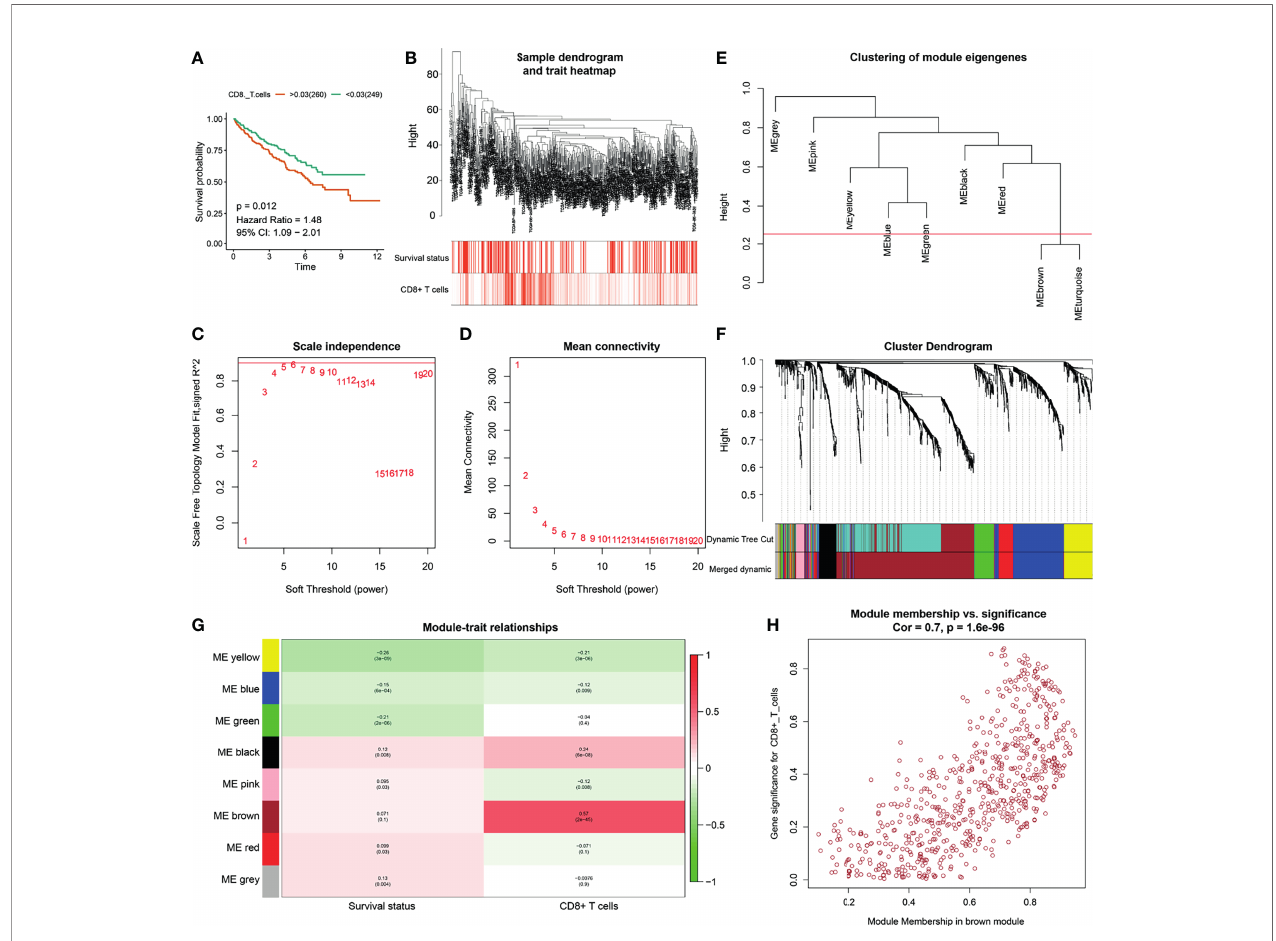
FIGURE 1 | Identi fi cation of CD8 + T cell related genes. (A) Kaplan-Meier analysis of CD8 + T cells. (B) Clustering dendrograms of immune-related differentially expressed genes (IRDEGs). Color intensity varies positively with abundance of CD8 + T cells. In terms of survival status, red means dead and white indicates live. (C, D) Analysis of scale-free fi t index (C) and mean connectivity (D) for various soft-thresholding powers. (E) Clustering of module eigengenes. The red line shows cut height (0.25). (F) Dendrogram of robust IRDEGs clustered based on a dissimilarity measure (1-TOM). (G) Heatmap of the correlation between module eigengenes and clinical traits of ccRCC. Each cell contains p-value and the correlation coef fi cient. (H) Scatter plot of module eigengenes related to abundance of CD8 + T cells in the brown